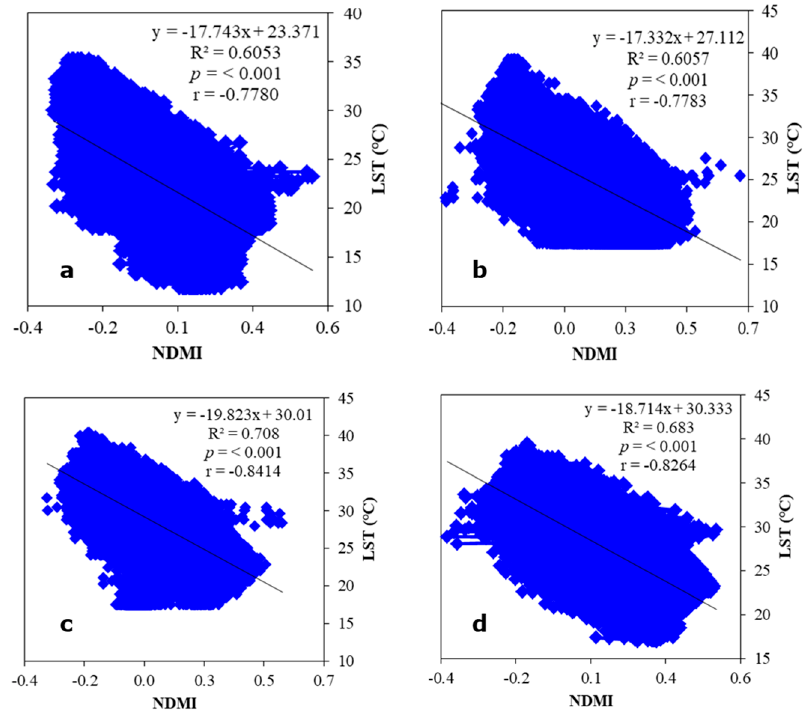
Figure A4. Scatter Plots between LST and NDMI for ( a ) 1988; ( b ) 1998; ( c ) 2008; ( d ) 2018.